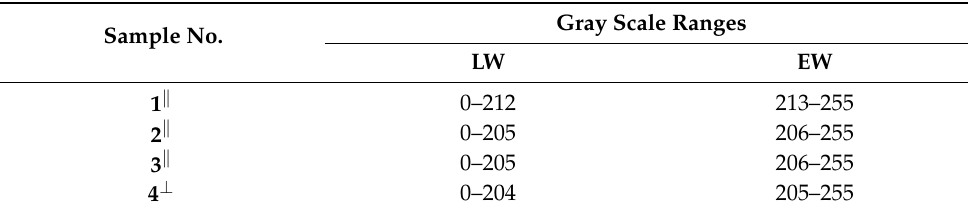
Figure 3. Schematic view of the generation of digital twins of the blank samples by the gray scale mapping scheme. Table 1. Gray scale ranges for the mapping of early wood (EW) and late wood (LW) zones of all samples.